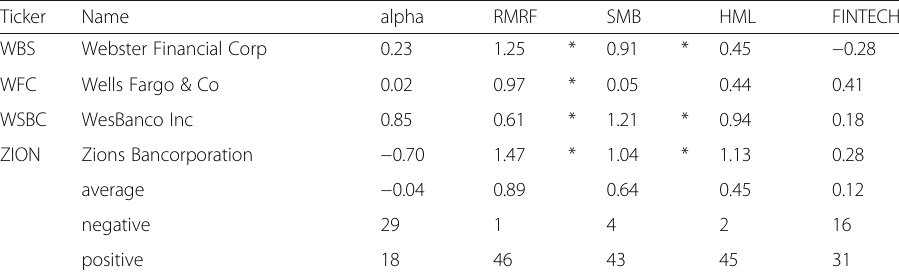
Table 5 OLS Regression Results of Models with FinTech Volume Growth (Continued)